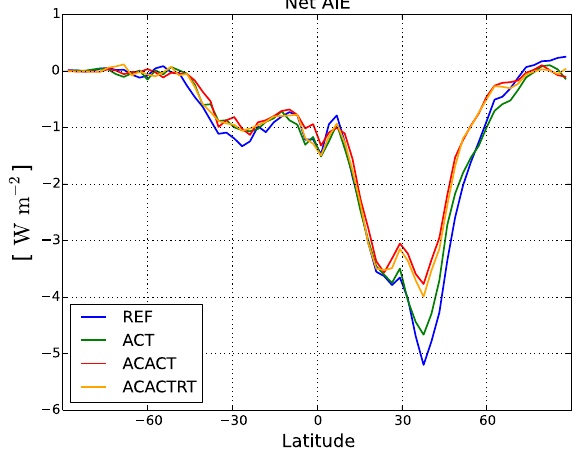
Figure 6. The net aerosol indirect effect (AIE) for each model con- figuration in W m − 2